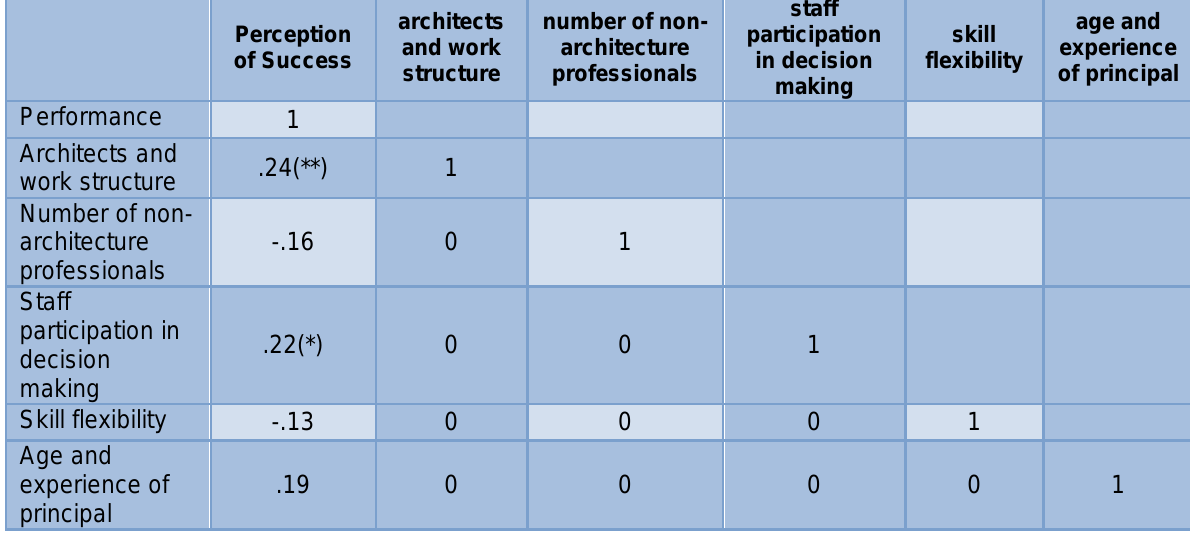
Table 2 Correlations ** Correlation is significant at the 0.01 level (2-tailed), * Correlation is significant at the 0.05 level